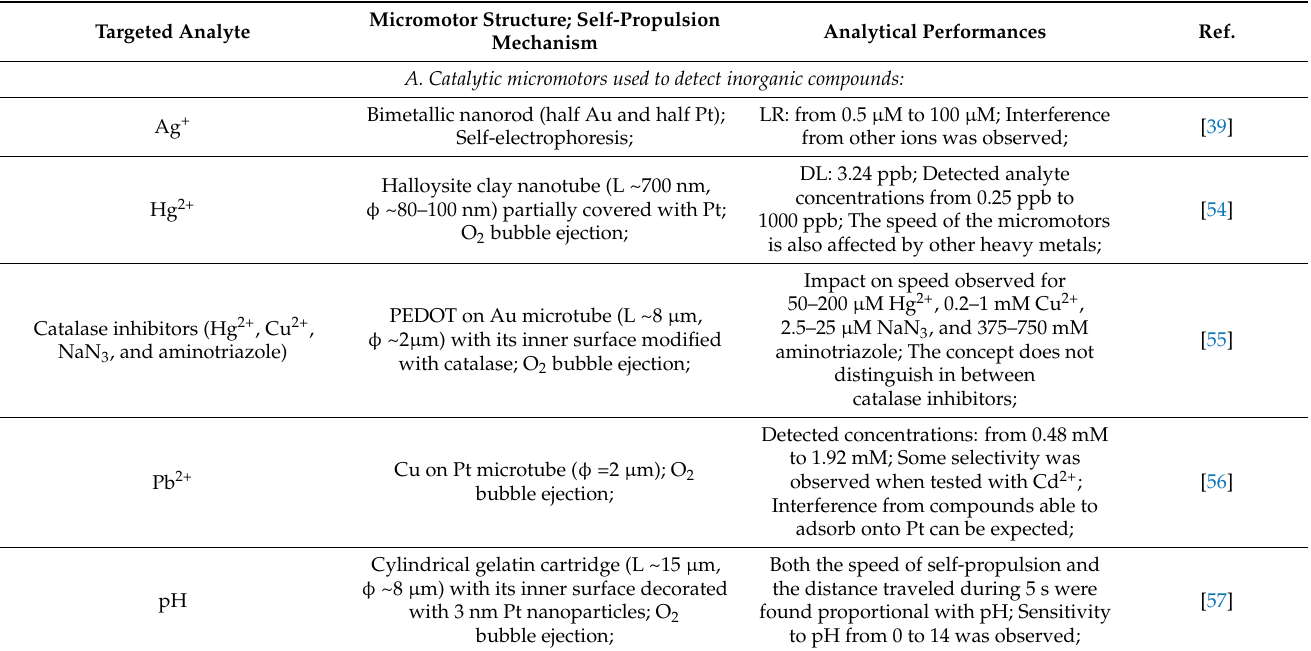
Table 2. Examples of catalytic micromotors which were used to detect analytes which modulate the speed of self-propulsion without being fuel for the catalytic micromotors; (Used abbreviation: BSA = bovine serum albumin).